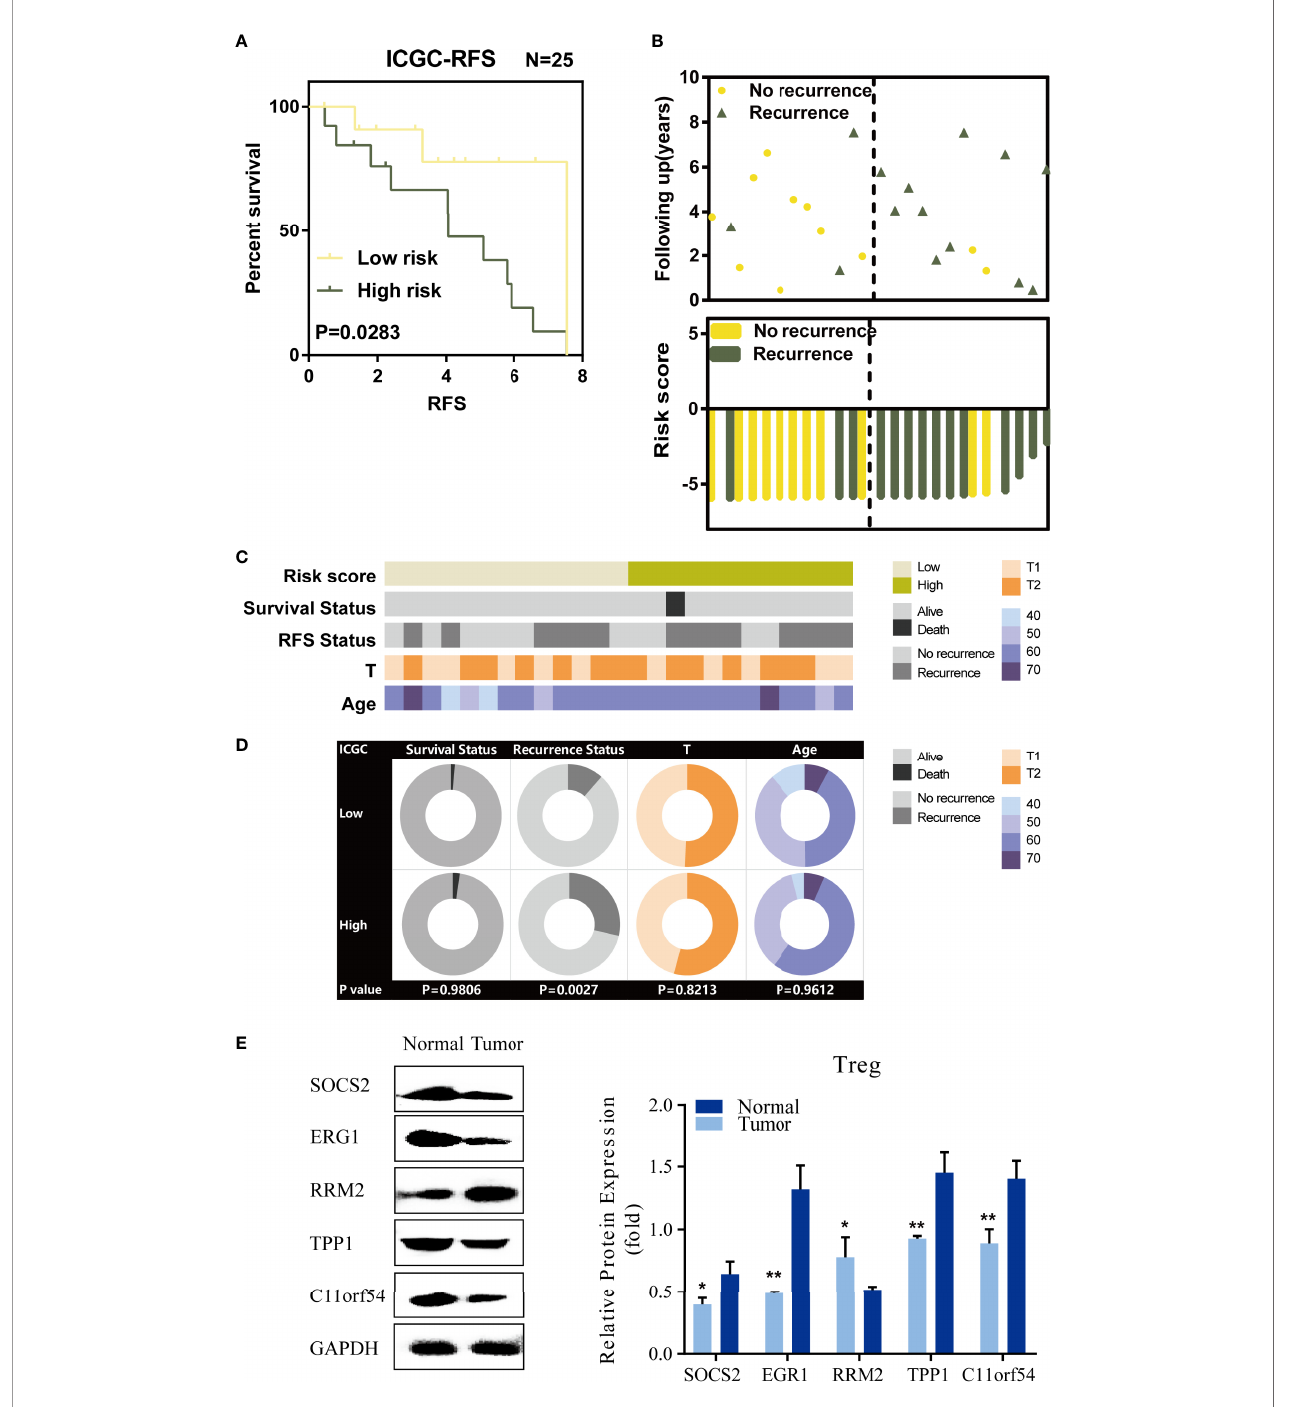
FIGURE 3 | Validation of TILTregSig in the ICGC database and experimental data. (A) Kaplan – Meier curves of RFS of low- and high-risk groups strati fi ed by the TILTregSig in prostate cancer patients in the ICGC dataset. (B) The distribution of gene risk scores and patients ’ recurrence status for prostate cancer patients in the ICGC dataset. (C) The strip chart of risk score and clinical characteristics for patients with prostate cancer in the ICGC dataset. (D) Pie charts showing the chi- square test of clinicopathologic factors for low- and high-risk groups in prostate cancer samples from the ICGC dataset. (E) Comparison of the expression of fi ve genes (SOCS2, EGR1, RRM2, TPP1, and C11orf54) based on our TILTregSig between Tregs excavated from PBMC of 3 healthy donors and 3 prostate cancer patients using Western blot analysis. *, P<0.05. **,